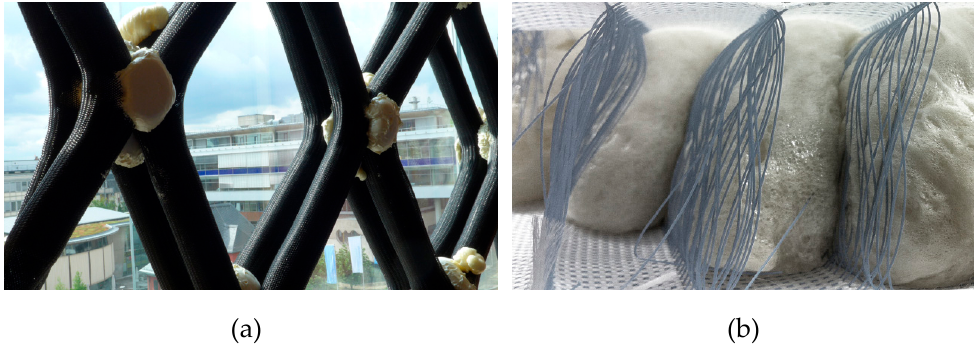
Figure 9. Textiles for free-form architectures in glass facades (reproduced from [70] under the terms and condition of CC BY-NC 4.0 license): ( a ) external coating composed of pressure-resistant lightweight ropes made of foamed textile sleeves, and ( b ) cross-sectional detail of a 3D textile-foam spacer fabric solution.